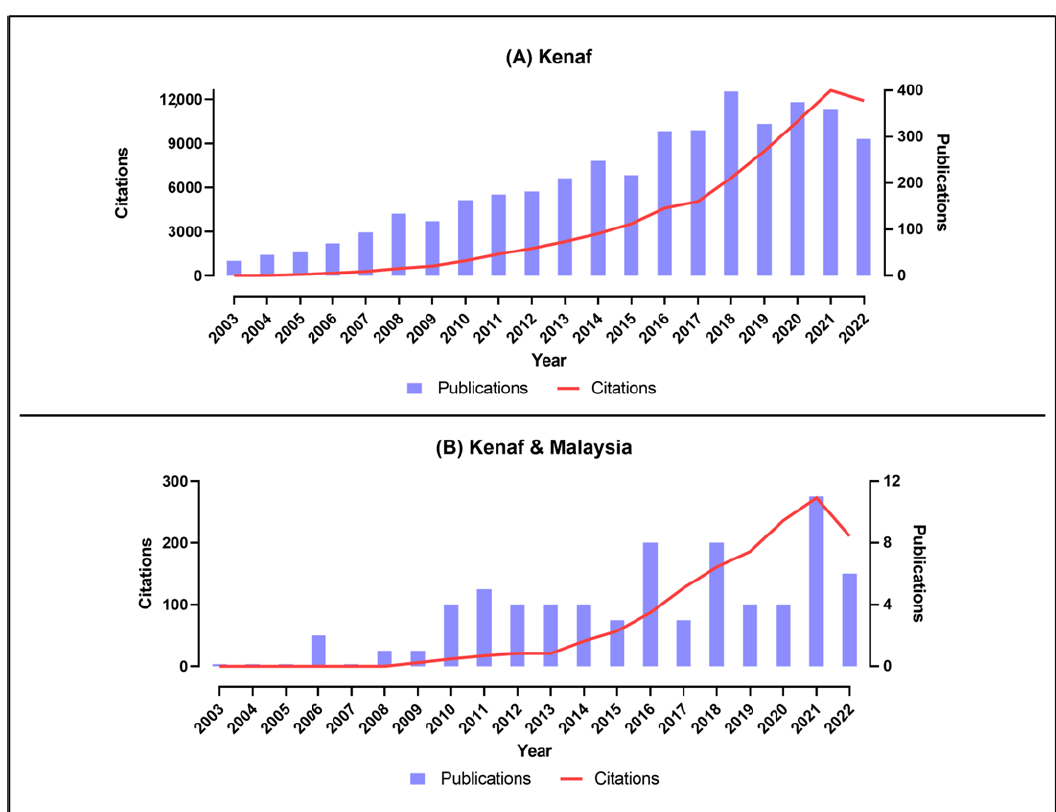
Figure 2. Publication and citation trends of kenaf from 2003 to 2022 using the keywords ( A ) Kenaf and ( B ) Kenaf and Malaysia. Data retrieved from Web of Science.